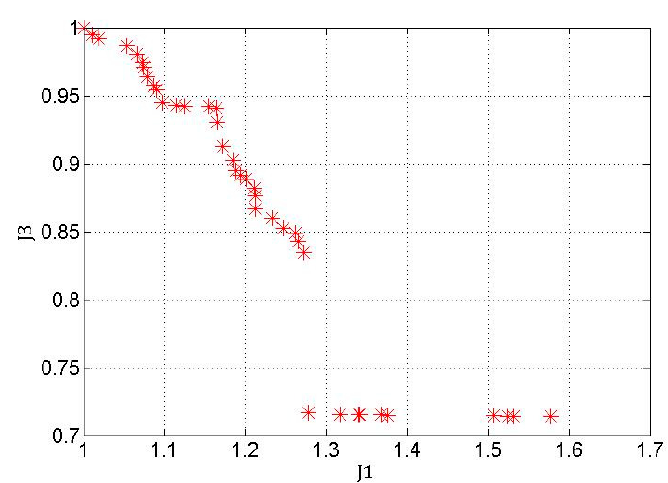
Figure 7. Flow chart of NSGA-II (Kim et al. [38]).